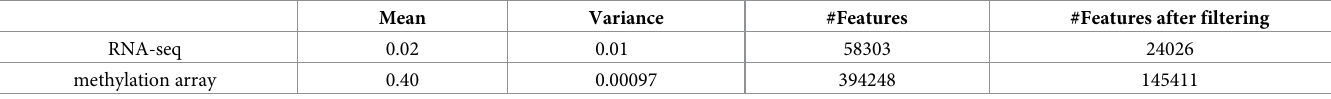
Table provides the thresholds used for mean and variance filtering of the features to be used as input for matrix factorization and the total number of features selected as a result.